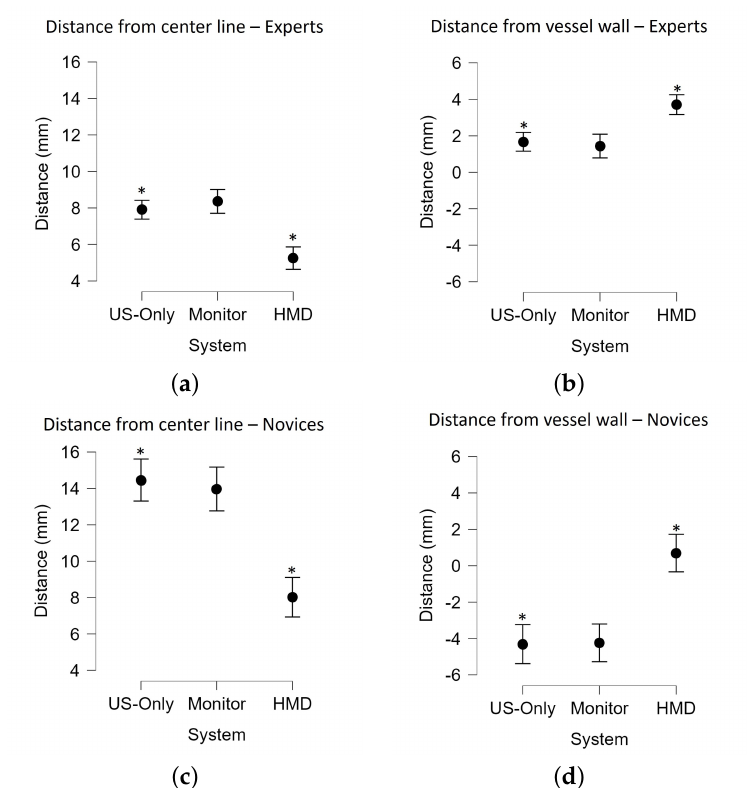
Figure 6. ( a ) Distance metrics presented with respect to system where ( a , c ) summarize the distances from the final needle tip position to the closest point on the center line of the vessel for experts and novices, respectively, and ( b , d ) summarize the distances from the final needle tip position to the closest point on the vessel wall for experts and novices, respectively. Metrics with significant differences between systems ( p < 0.05) are denoted with